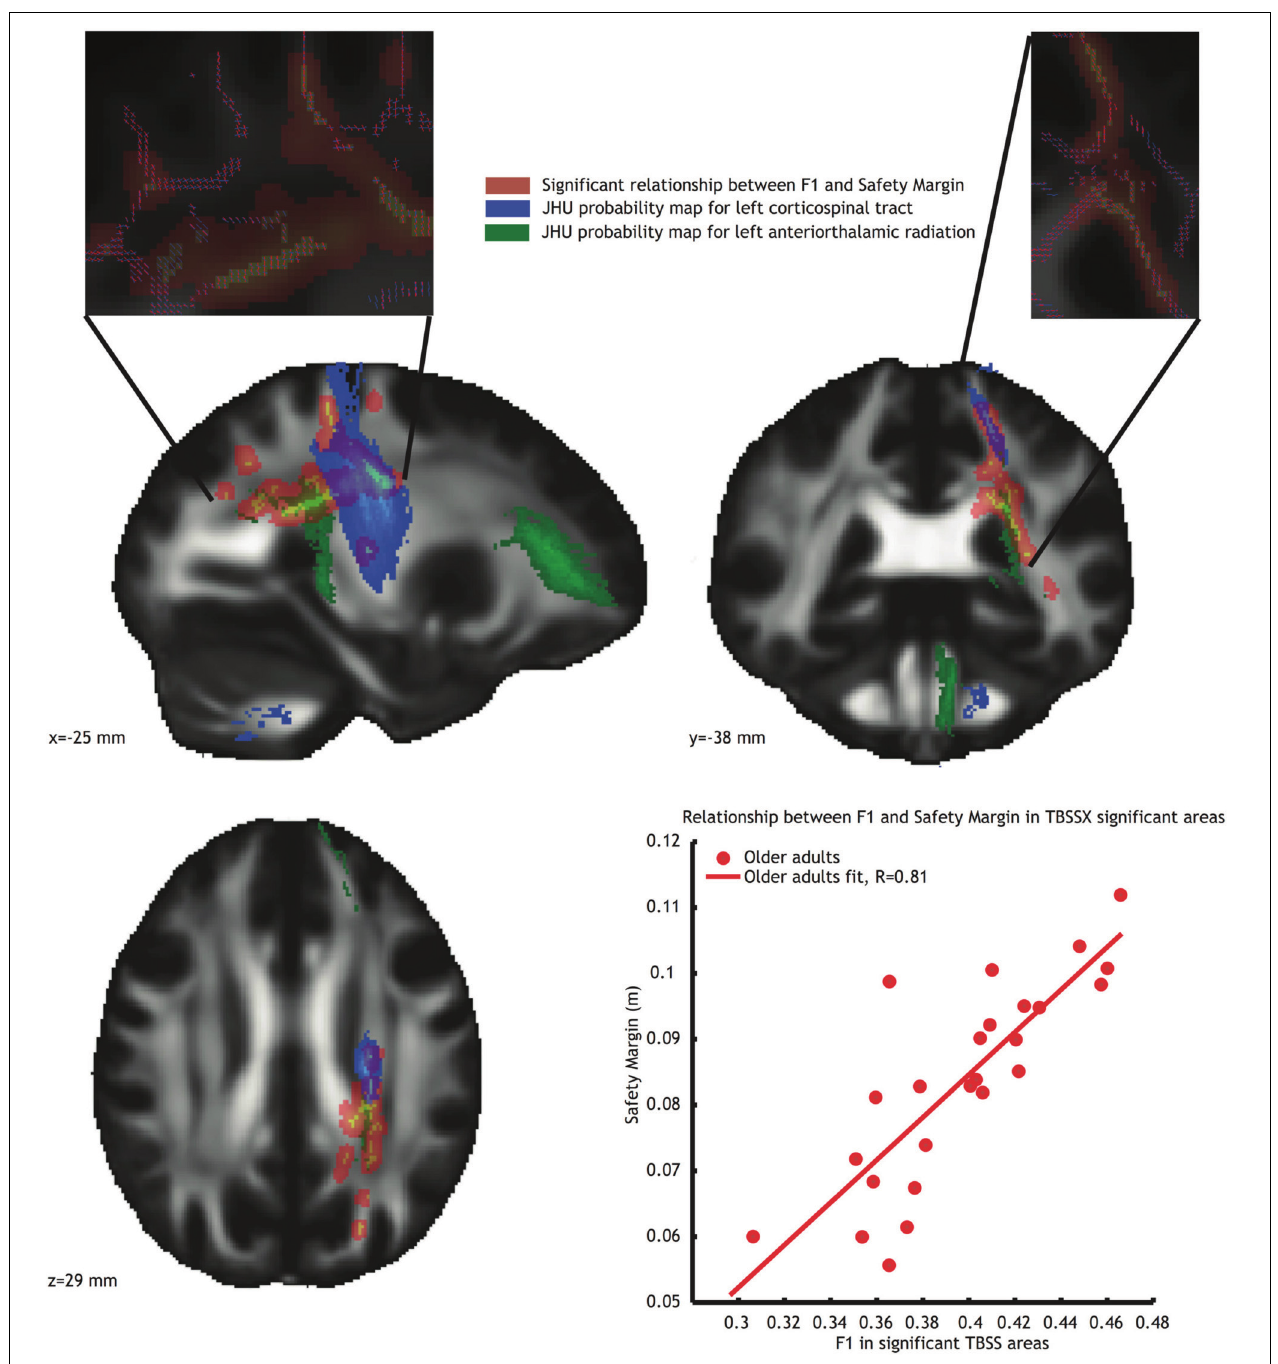
FIGURE 4 | Voxels showing significant correlations ( P < 0 . 05, TFCE corrected) between FA in partial volume F1 and safety margin (Orange) in the older adults group. Blue voxels represent the JHU probability map of the left corticospinal tract, green voxels represent the JHU probability map of